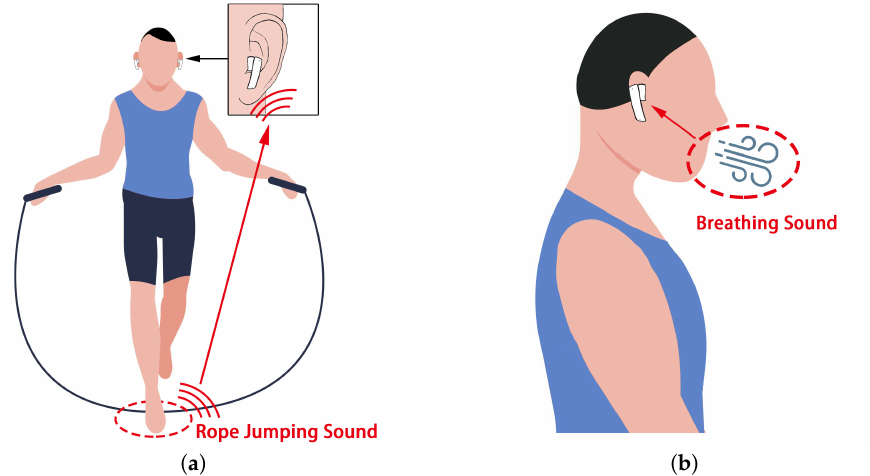
Figure 1. Application scenarios. ( a ) Capturing the rope jumping sound for rope jumping counting. ( b ) Capturing the breathing sound for evaluating exercise